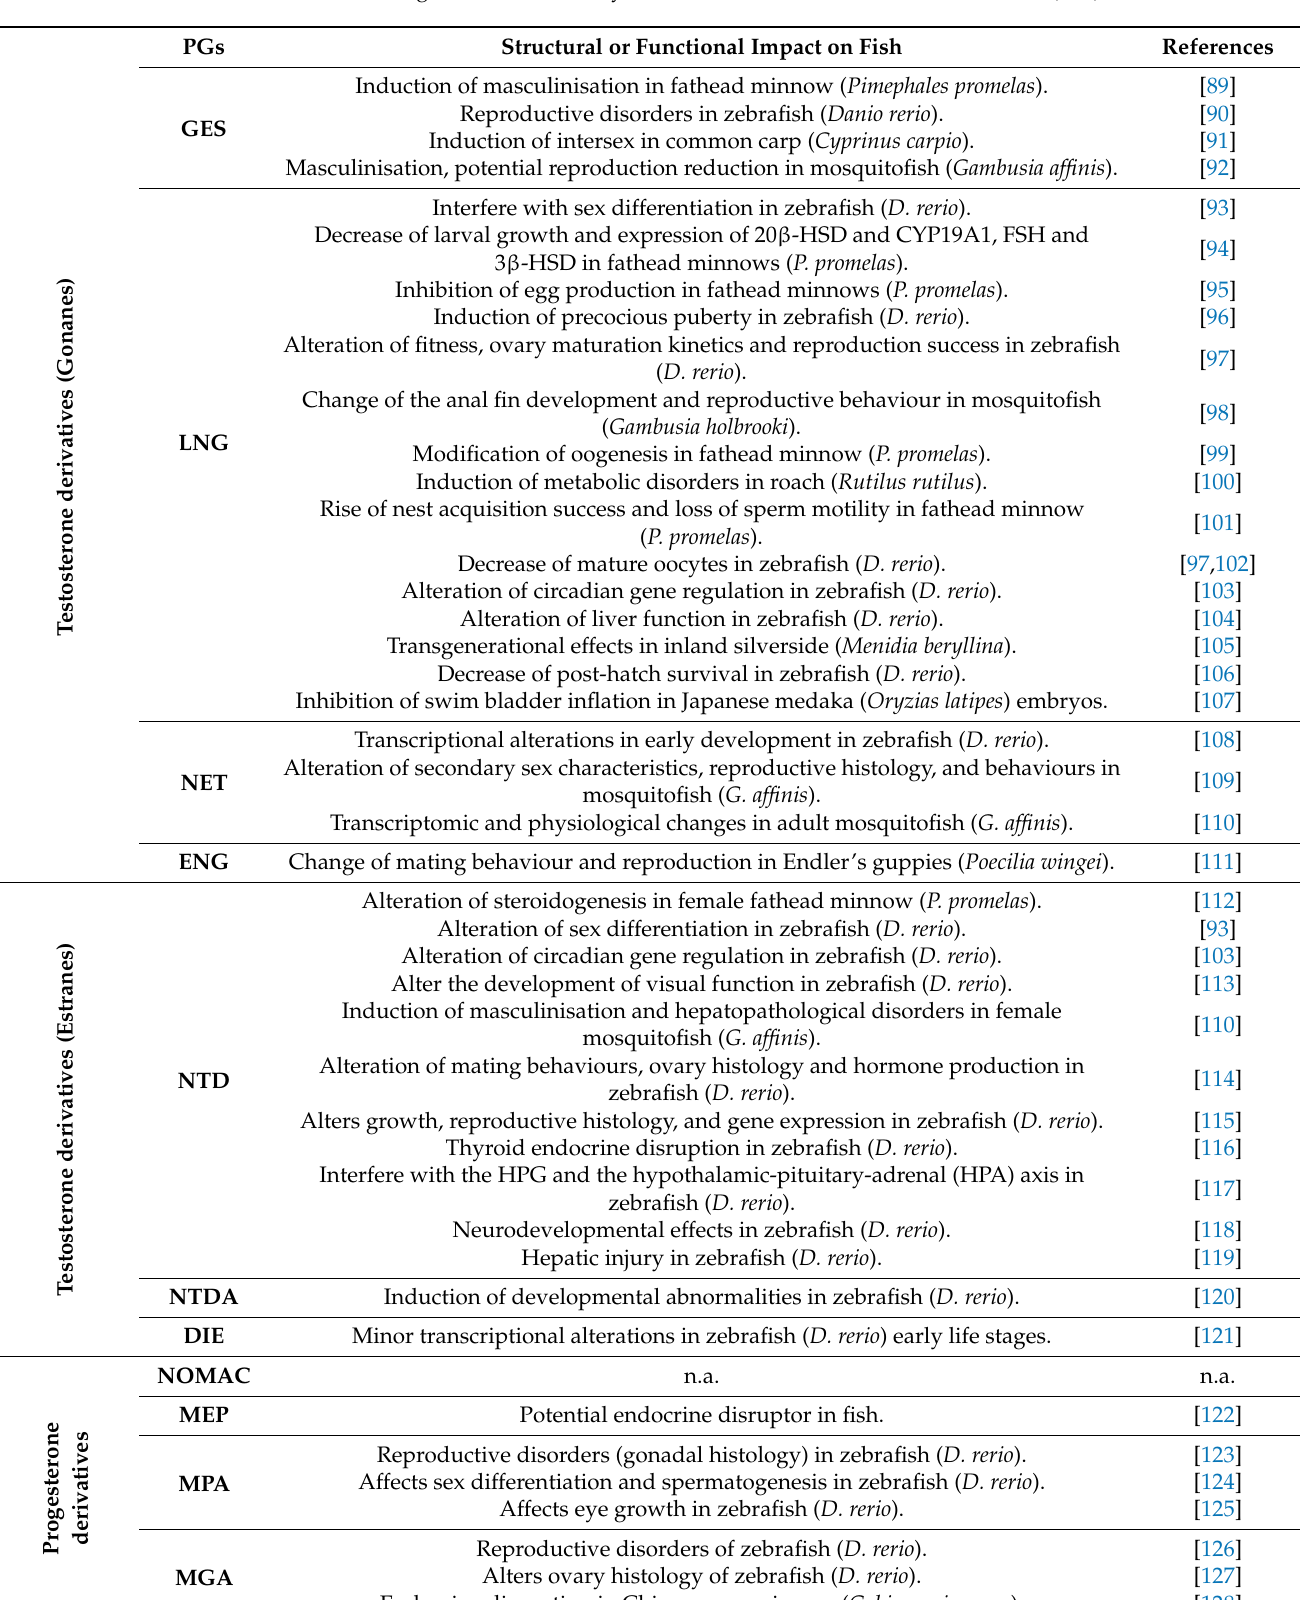
Table 5. Data retrieved from “Web of Science Core Collection”, covering years from 2015 to 2021, concerning the effects of the synthetic PGs in fish. No data were available (n.a.) for